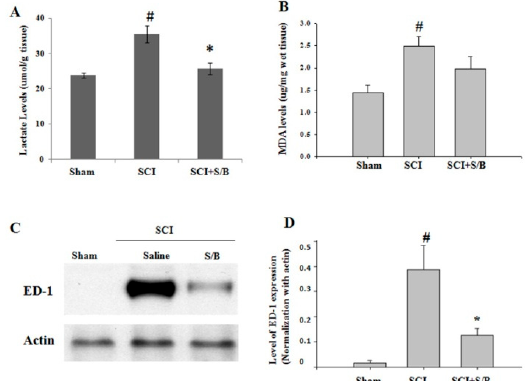
Figure 5. Effects of three consecutive intraperitoneal administration of S/B remedy on injured spinal cords of SCI rats. SCI rats with or without S/B remedy (20 mg/kg) treatment were sacrificed at the third day after SCI, and the injured epicenter of thoracic spinal cords (about 1.5 cm) was rapidly removed and longitudinal dissected into equal 2 segments. One half of the cords was homogenized and processed for measurement of ( A ) lactate or ( B ) lipid peroxidation malondialdehyde (MDA) level. The other half of the cords was homogenized and processed for ( C ) and ( D ) western blot analysis of ED ‐ 1 expression. # and * P < 0.05 indicate statistical significance as compared with Sham group and SCI group, respectively, by one ‐ way ANOVA and Student–Newman–Keuls Method.